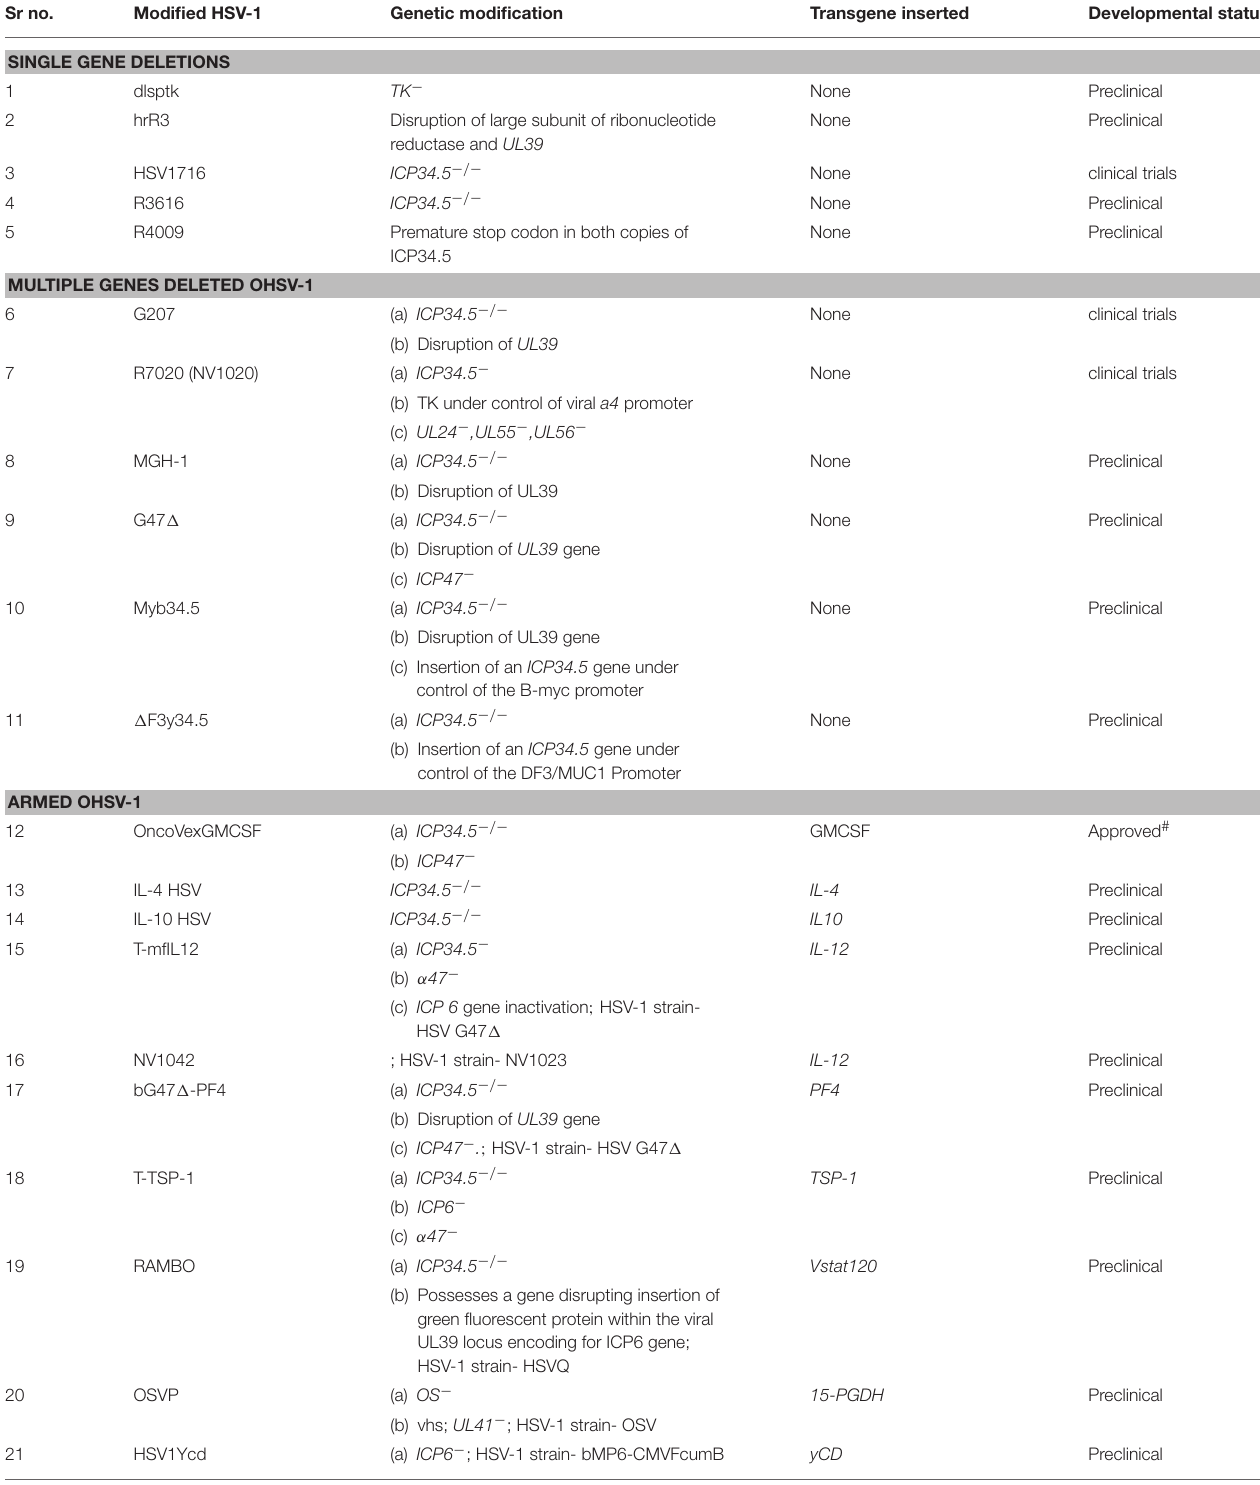
TABLE 1 | List of oncolytic herpes simplex virus-1 develpoed. Sr